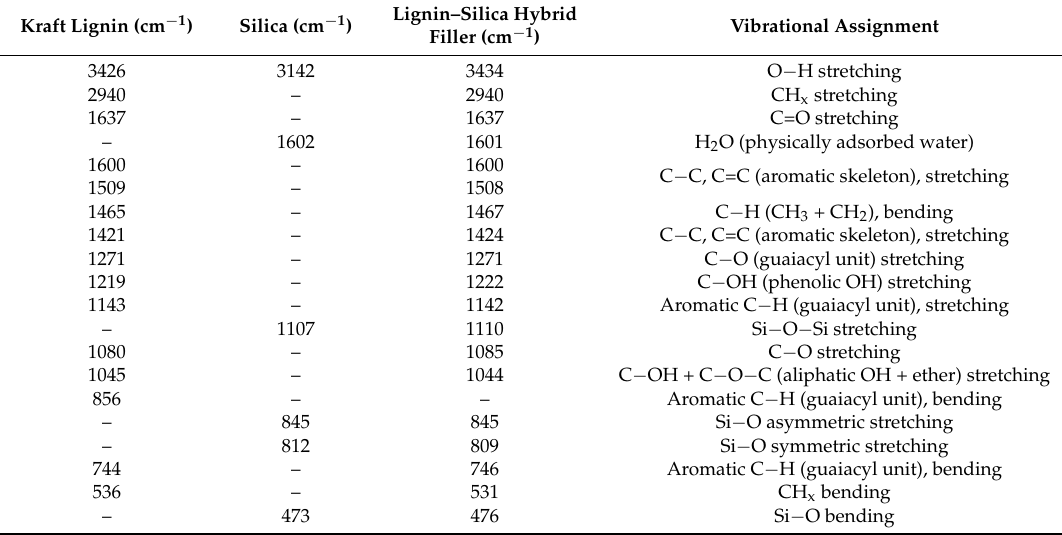
Table 1. Vibrational frequency wavenumbers (cm ´ 1 ) observed for lignin, silica and lignin–silica hybrid